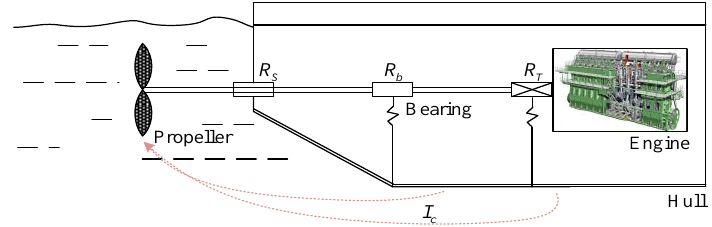
Figure 1. Mechanical structure of the hull tail.